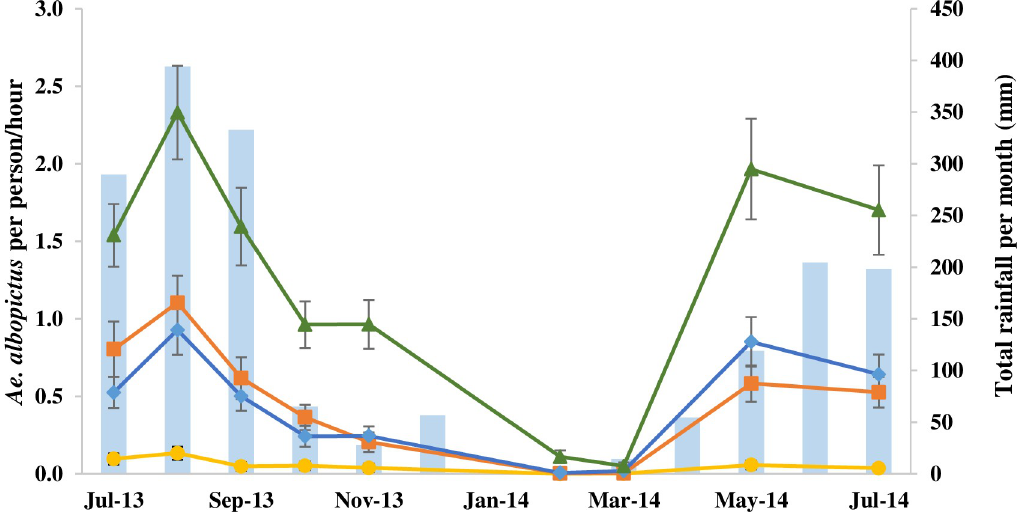
Fig 2. The average number of female Aedes albopictus collected per person per hour during the nine months of collection from July 2013 to July 2014 ( ▬▲▬ secondary forests, ▬♦▬ mature plantations, ▬■▬ immature plantations, ▬●▬ villages).